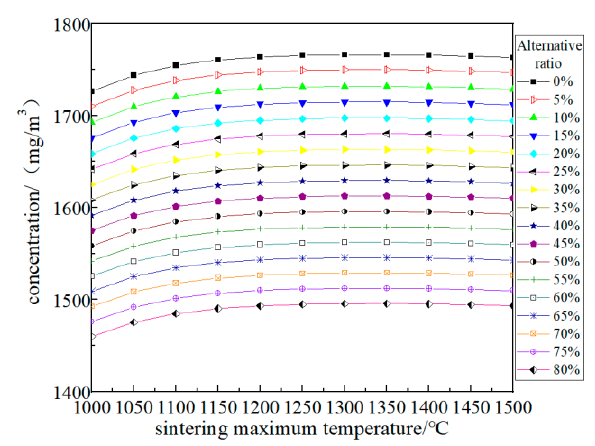
Figure 8. Change of SO 2 emission concentration in the case of straw charcoal